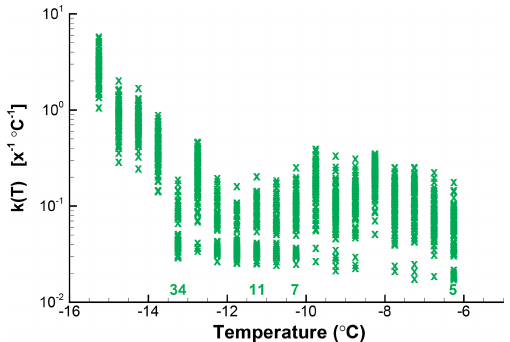
Figure 7. Calculated k(T ) values for 100 iterations of random as- signments of (cid:49)N from a Poisson distribution with the λ values shown in Table 3 for each interval. Numbers above the abscissa indicate the number of zero values in the simulation for selected temperatures.